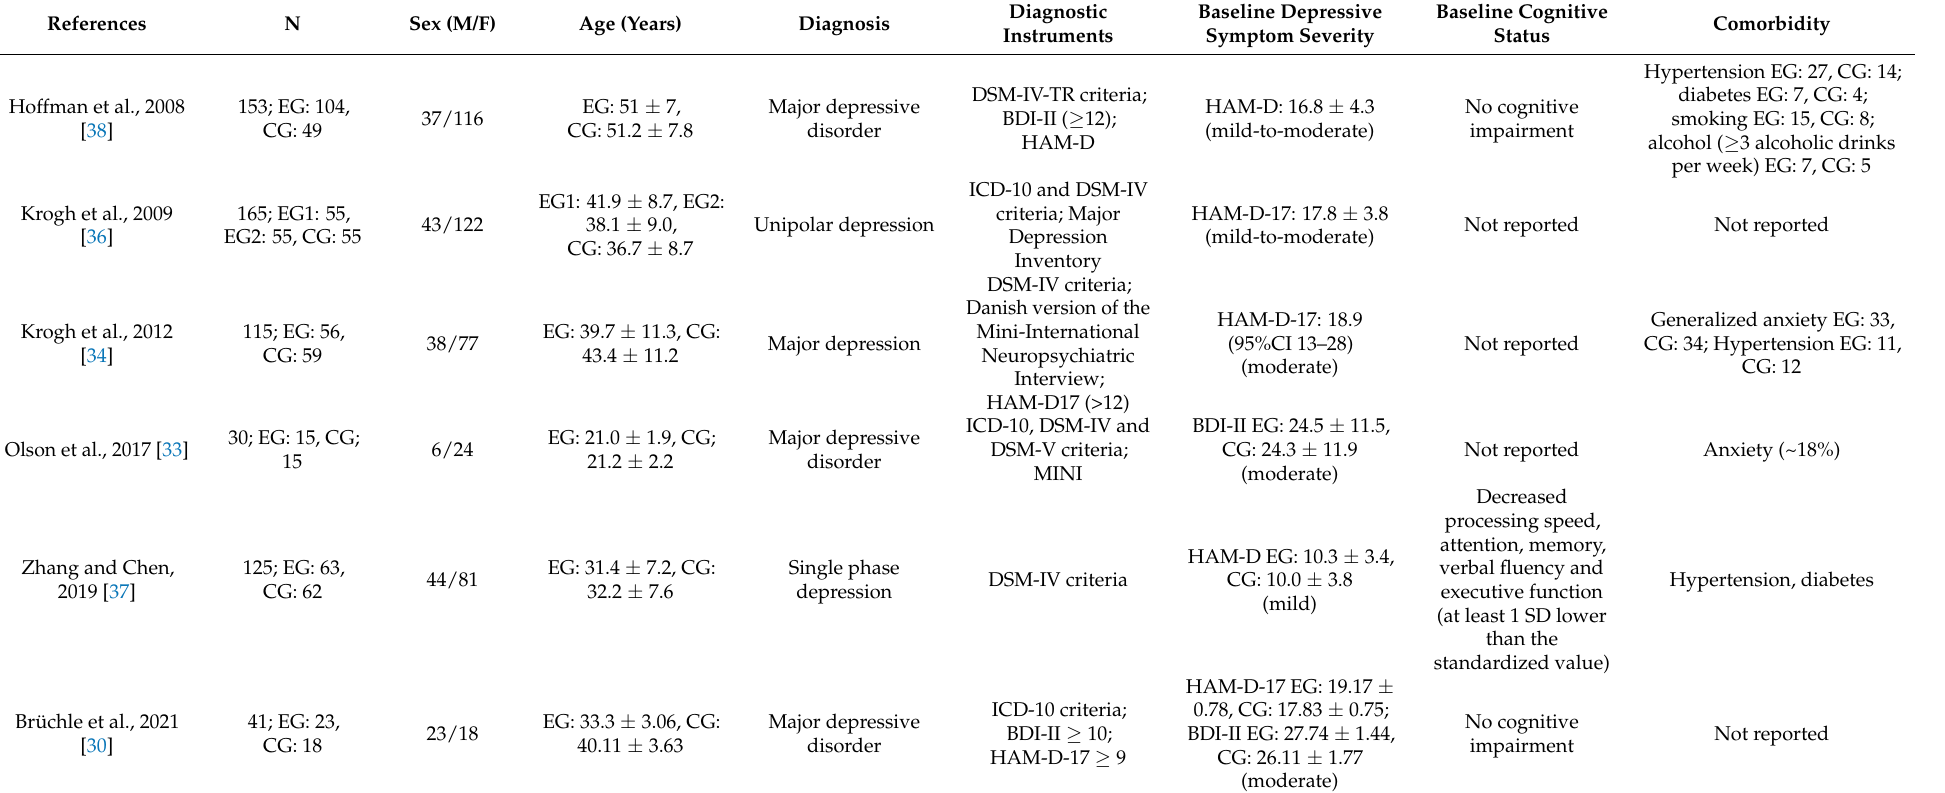
Table 2. Subjects’ characteristics from the studies